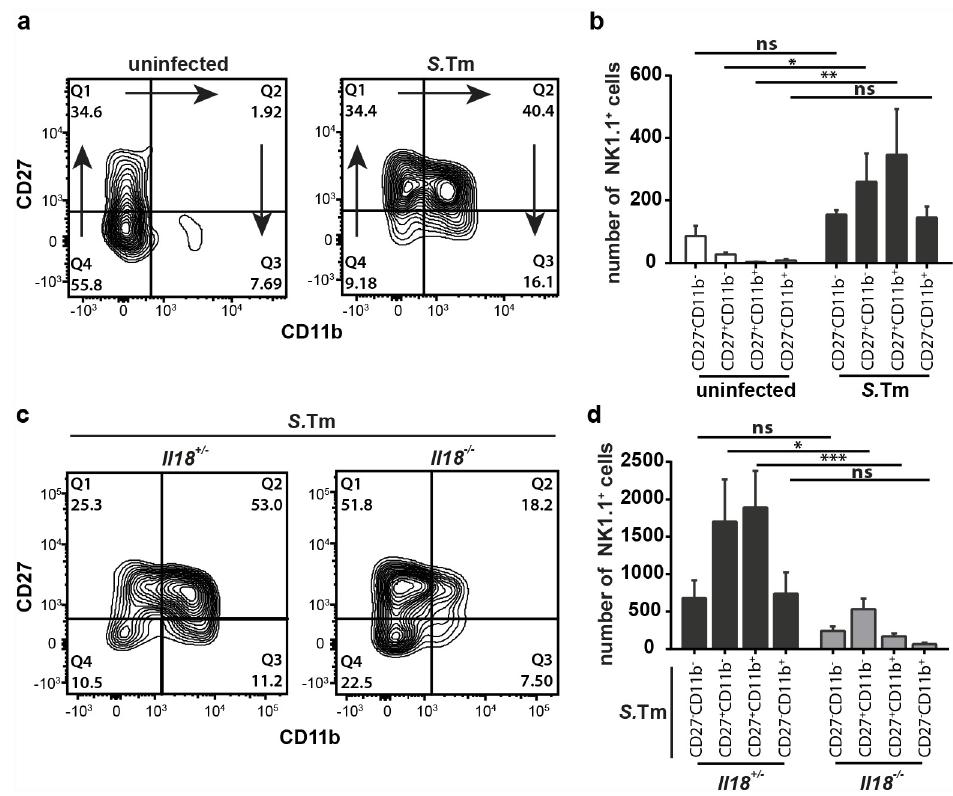
Fig 5. NK cells in the infected cecal mucosa of IL-18-deficient mice are phenotypically immature. (a and b) Flow cytometric analysis of isolated cecal LP cells from Sm-pretreated C57BL/6 WT mice, either uninfected or infected with 5x10 7 CFU S .Tm (n = 5 per group). We gated on single live CD45 + CD3 - NK1.1 + cells. (a) Representative contour plots and (b) quantification of NK cell maturation stages, defined by the surface expression of CD27 and CD11b; arrows indicate the progression of NK-cell maturation. (c and d) Flow cytometric analysis of isolated cecal LP cells from Il18 -/- mice and littermates, Sm-pretreated and orally infected with 5x10 7 CFU S .Tm for 12h (n = 5 – 6 per group). We gated on single live CD45 + CD3 - NK1.1 + cells. (c) Representative contour plots and (d) quantification of NK cell maturation stages based on CD27 and CD11b surface expression. Data represent the mean ± SD and statistical analyses were performed using 2way-ANOVA with Sidak ’ s multiple comparison test (ns = not significant, * = p < 0.05; ** = p < 0.01; *** = p <